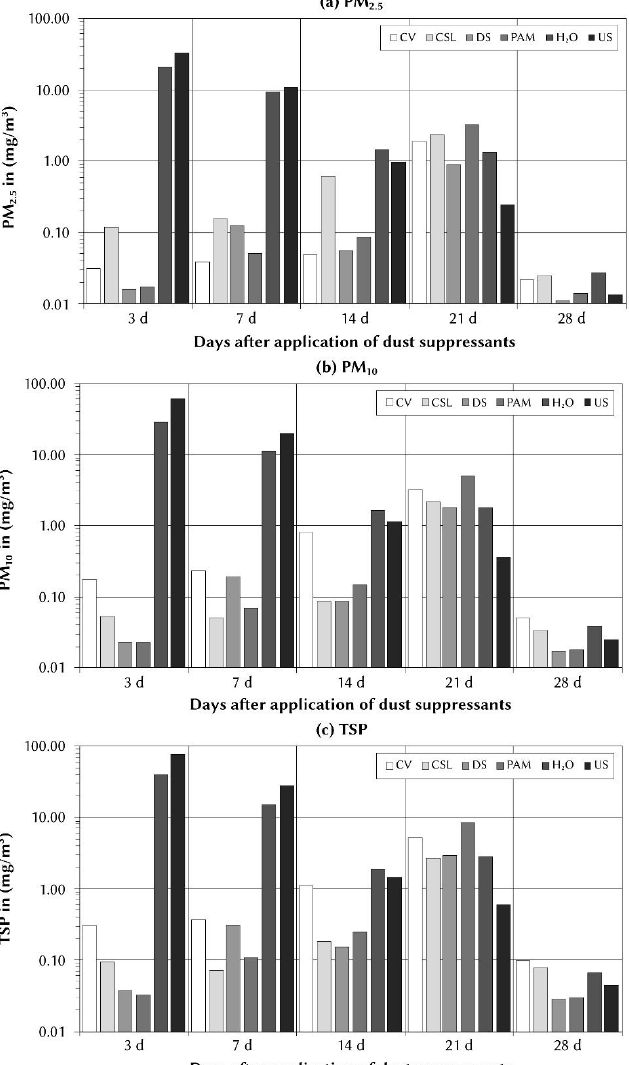
Figure 6. Wind-induced dust emissions from treated and untreated mine soils (mean values, n = 3): ( a ) PM 2.5 , ( b ) PM 10 , and ( c ) TSP. Dust emissions were measured 3, 7, 14, 21, and 28 days after application of dust suppressants. Abbreviations: CV = chicory vinasses, CSL = corn steep liquor, DS = decantation syrup, PAM = palatinose molasses, H 2 O = water-treated soil, US = untreated